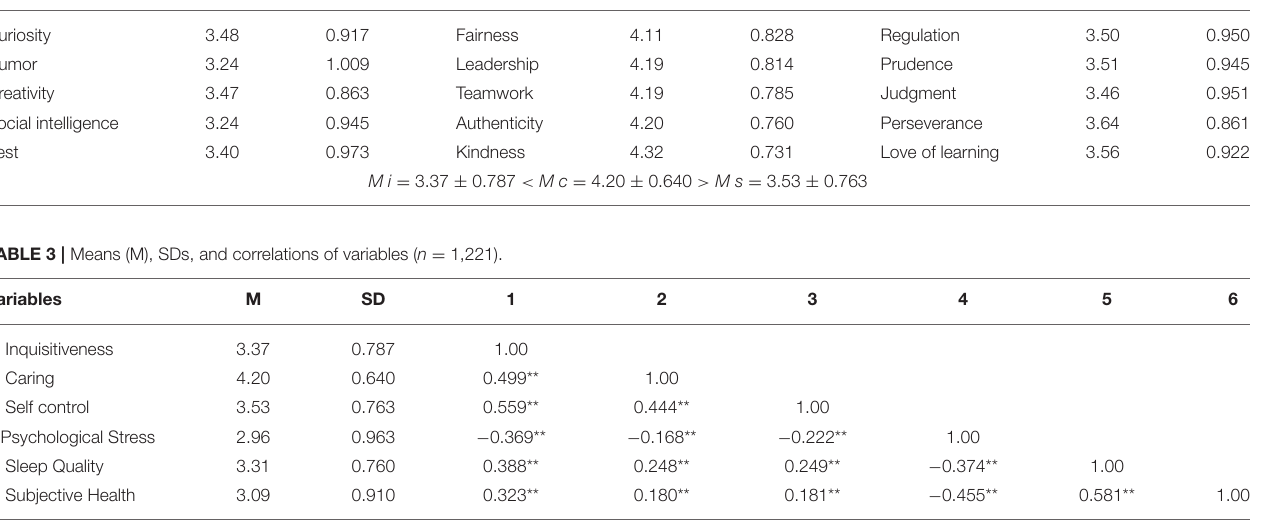
TABLE 2 | Means (M) and SDs of the 15-item three-dimensional inventory of CS ( n = 1,221). Inquisitiveness M SD Caring M SD Self- control M SD Curiosity